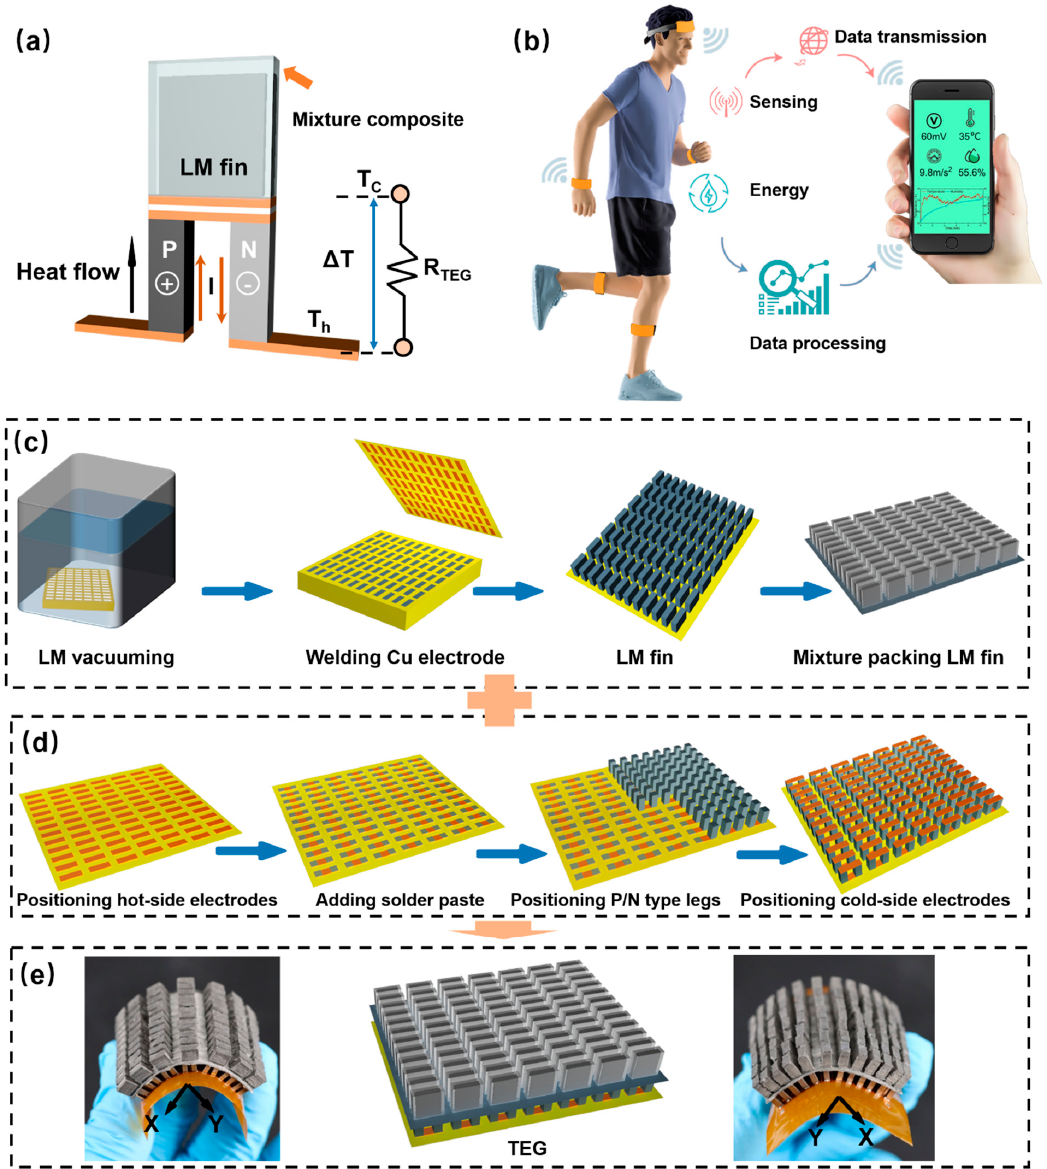
Figure 1. LM-WTEG working principle and preparation process: ( a ) the working principle of LM- WTEG; ( b ) application of LM-WTEG for powering the wearable sensor system; ( c ) flexible LM finned heat sink preparation based on template method; ( d ) WTEG preparation based on flexible printed circuit board; ( e ) biaxial bending of WTEG integrated with LM